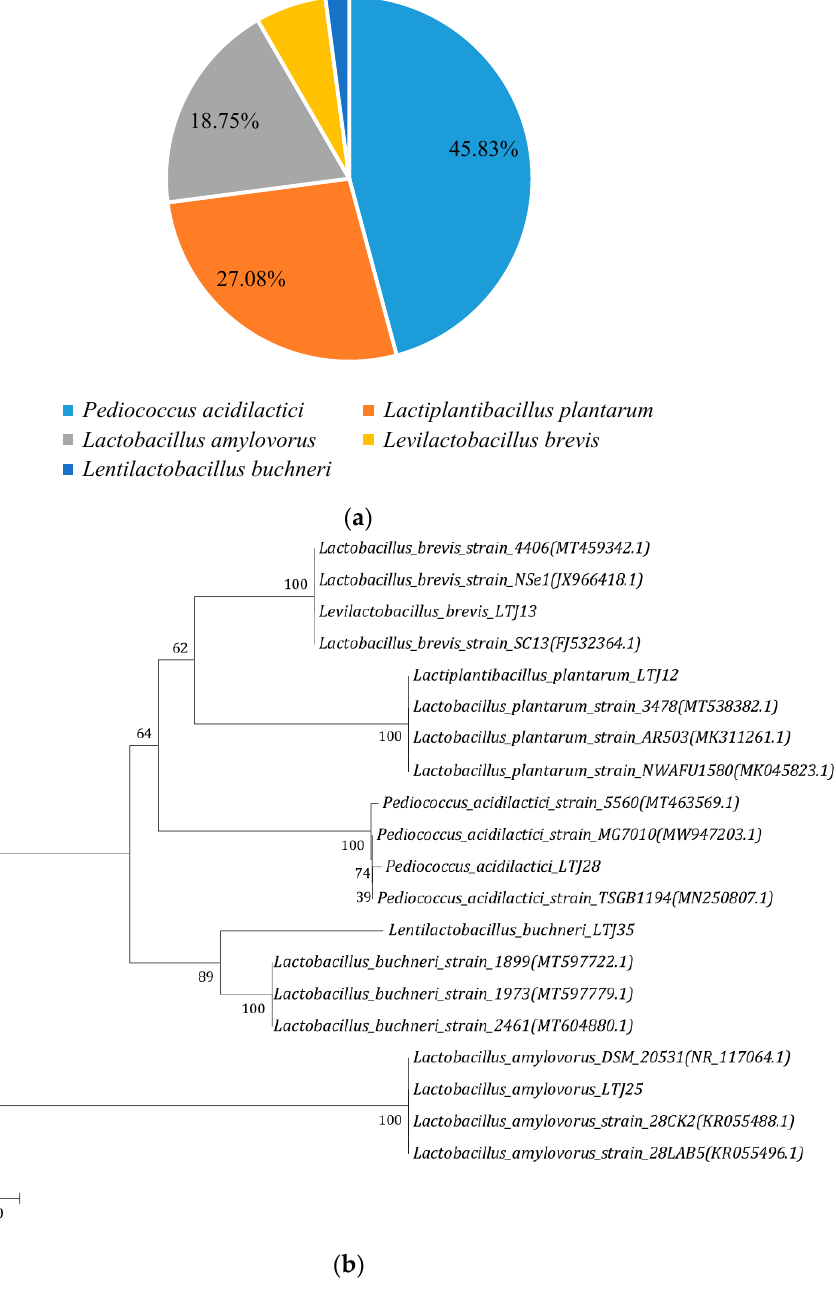
Figure 3. ( a ) Pie graph of species of lactic acid bacteria in the fermented grains of soy sauce aroma type baijiu and ( b ) phylogenetic tree based on 16S rDNA of typical strains.